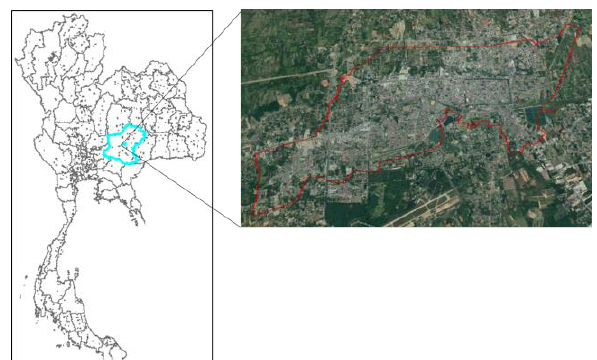
Figure 1. Location of MNC in Thailand.